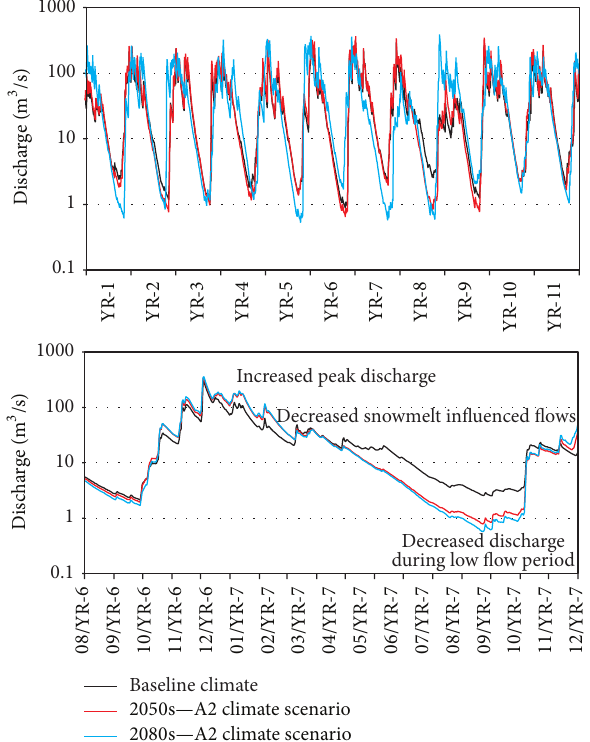
Figure 18: Simulated Cowichan River flows under baseline and climate change